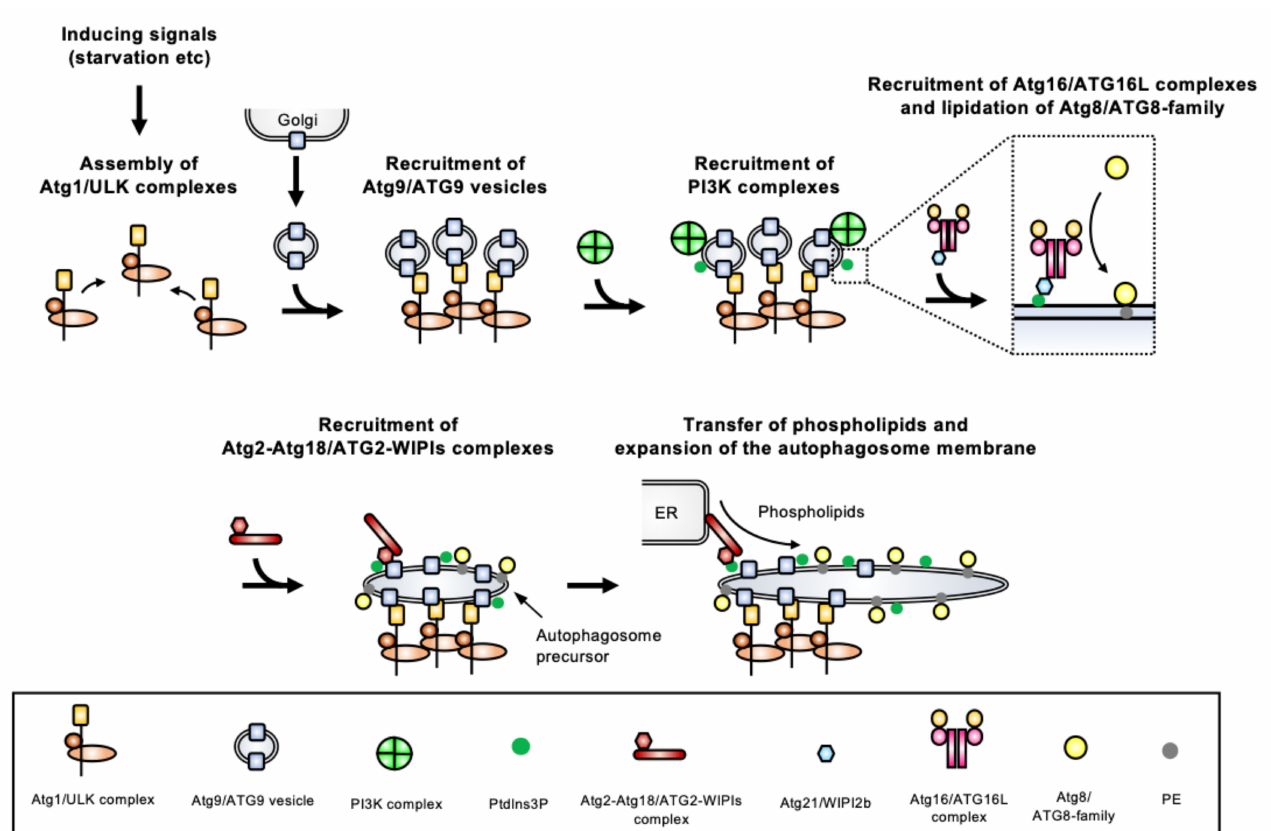
Figure 2. Schematic model for the molecular process of autophagosome biogenesis in Opisthokonta. Autophagy inducing signals, such as starvation, stimulate the assembly of the Atg1/ULK complex, which is a platform for initiating autophago- some formation. Then, Golgi apparatus-derived Atg9/ATG9 vesicles are recruited to the platform and may be seeds for autophagosome biogenesis. The PI3K complexes localize to this site after Atg9/ATG9 vesicles are recruited, and generate PtdIns3P. The PtdIns3P recruits the Atg16/ATG16L complexes to the vesicle depending on the PtdIns3P-binding activity of Atg21/WIPI2b, then proteins of the Atg8/ATG8 family are conjugated with PE on the vesicle. In addition, PtdIns3P recruits the Atg2-Atg18/ATG2-WIPIs complexes on the vesicles, and phospholipids are transferred to it from donor compartments such as ER by the lipid transfer activity of Atg2/ATG2. It enables the expansion of the autophagosome membrane. Since ATG8 homologs are localized on the autophagosome membrane from the beginning of its formation to the end of the degradation process, as shown in Figure 1, the protein is commonly used as a marker of